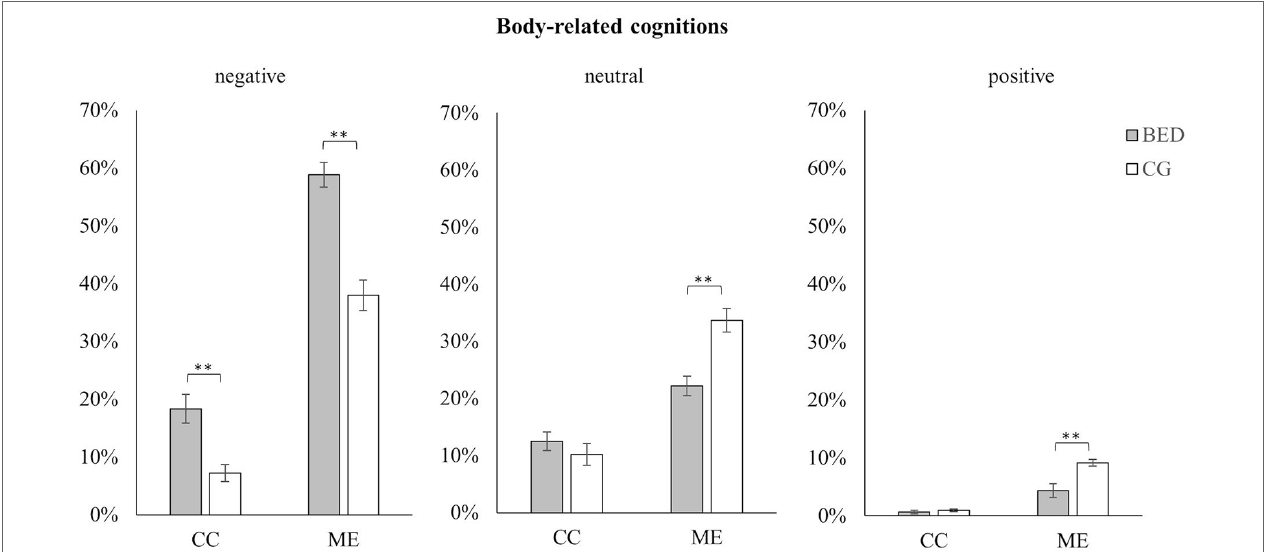
FIgURE 2 | Mean and standard error for negative, neutral, and positive body-related cognitions in women with BED and the control group (CG) during the control (CC) and the mirror exposure condition (ME).** p < .01.